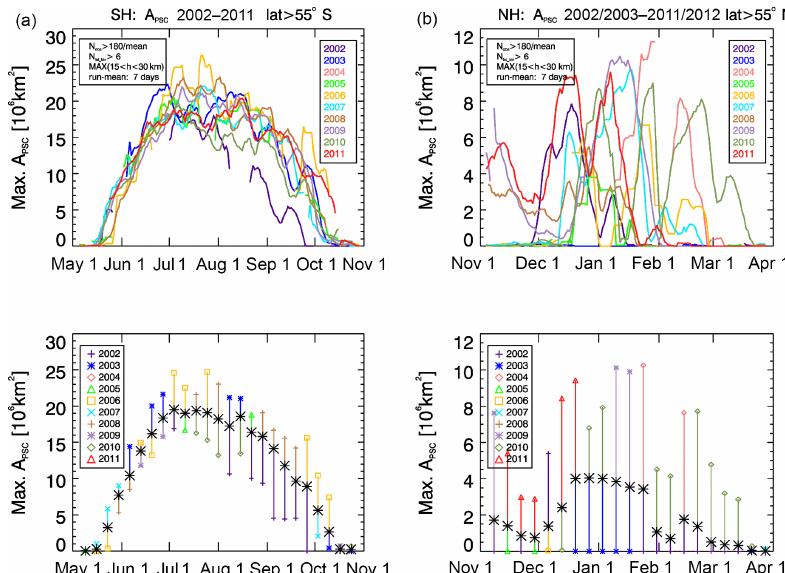
Figure 8. Maximum MIPAS area of PSC for SH (May–October, a ) and NH winter conditions (November–March, b ) computed as the running mean over 7 days through all seasons (top row). In addition, weekly maximum/minimum (colour-coded symbols) and mean values ( ∗ symbol) of A PSC are presented in the bottom row. For both types of representations, each season is colour coded, where for the NH the year in the figure legend (for example, 2002) is linked to the potential PSC season November 2002–March 2003, respectively. For the NH results, minimum values of zero appear for several years and the symbols are